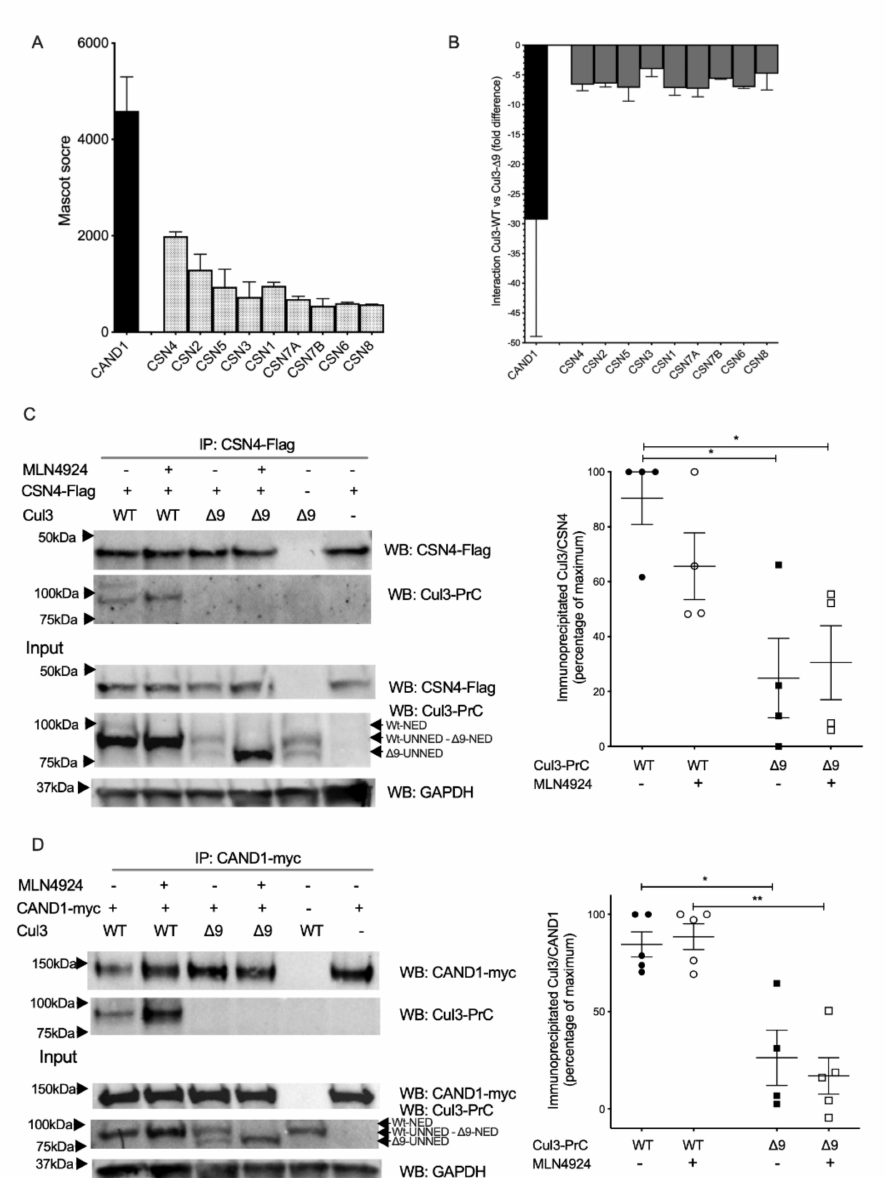
Figure 4. CUL3-WT and CUL3- ∆ 9 interactions with the COP9 signalosome and CAND1. PrC-CUL3- WT and PrC-CUL3- ∆ 9 were immunoprecipitated with HPC4 antibody, and the immunoprecipitated was analyzed by mass spectrometry. The abundance, as assessed by the Mascot score ( A ), and the difference in the interaction of each protein of the COP9 signalosome and CAND1 ( B ) with CUL3- WT and CUL3- ∆ 9 are shown. CSN4-Flag ( C ) and CAND1-myc ( D ) constructs were transfected in PrC-CUL3-WT or PrC-CUL3- ∆ 9-inducible cell lines (see Materials and methods). Cells were induced (or not) with tetracycline (10 µ g/mL) 32 h post-transfection and treated (or not) with MLN4924 (1 µ M) (Millenium Pharmaceuticals) 42 h post-transfection. Co-immunoprecipitation of CSN4-Flag or CAND1-myc was performed by incubating O/N the cell extracts with the corresponding Flag (M2, Sigma) and myc (9B11, cell signaling) monoclonal antibodies and protein G mag Sepharose beads (Healthcare GE) for 1 h, followed by SDS-PAGE and transfer to nitrocellulose. The left part shows a representative gel of the co-immunoprecipitation experiment, blotted with the HPC4 (CUL3) and Flag (CSN4) antibodies for C and HPC4 (CUL3) and myc (CAND1) antibodies for D. The bottom shows a Western blot of the same cellular extracts for CUL3, CSN4 (C), or CAND1 (D) and